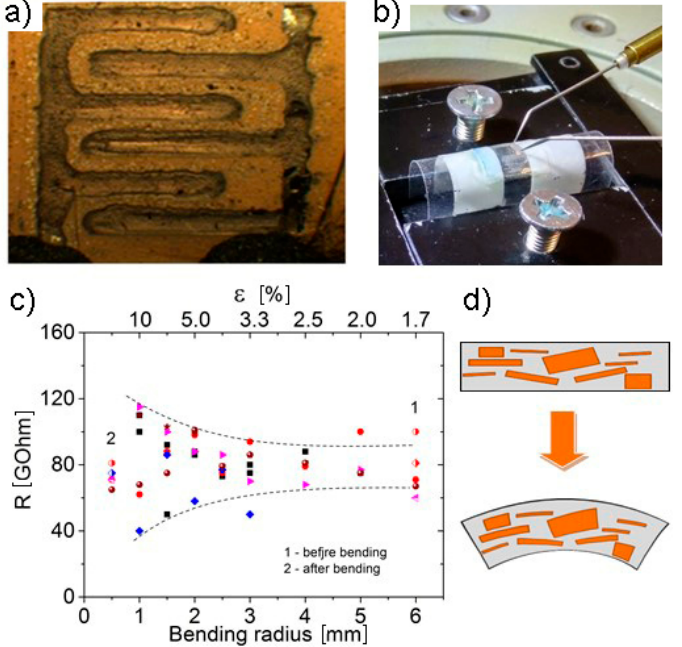
Figure 5. The optical image of ( a ) the structure created from the partially fluorinated graphene suspension with a thickness of about 30 nm on PET with Ag contacts and ( b ) shaped as two interdigital fingers. ( c ) Film resistance versus bending radius and strain at repeated measurements. Points 1 and 2 correspond to resistance before and after the bending. ( d ) Schematic representation of a film formed from flakes before and during bending.